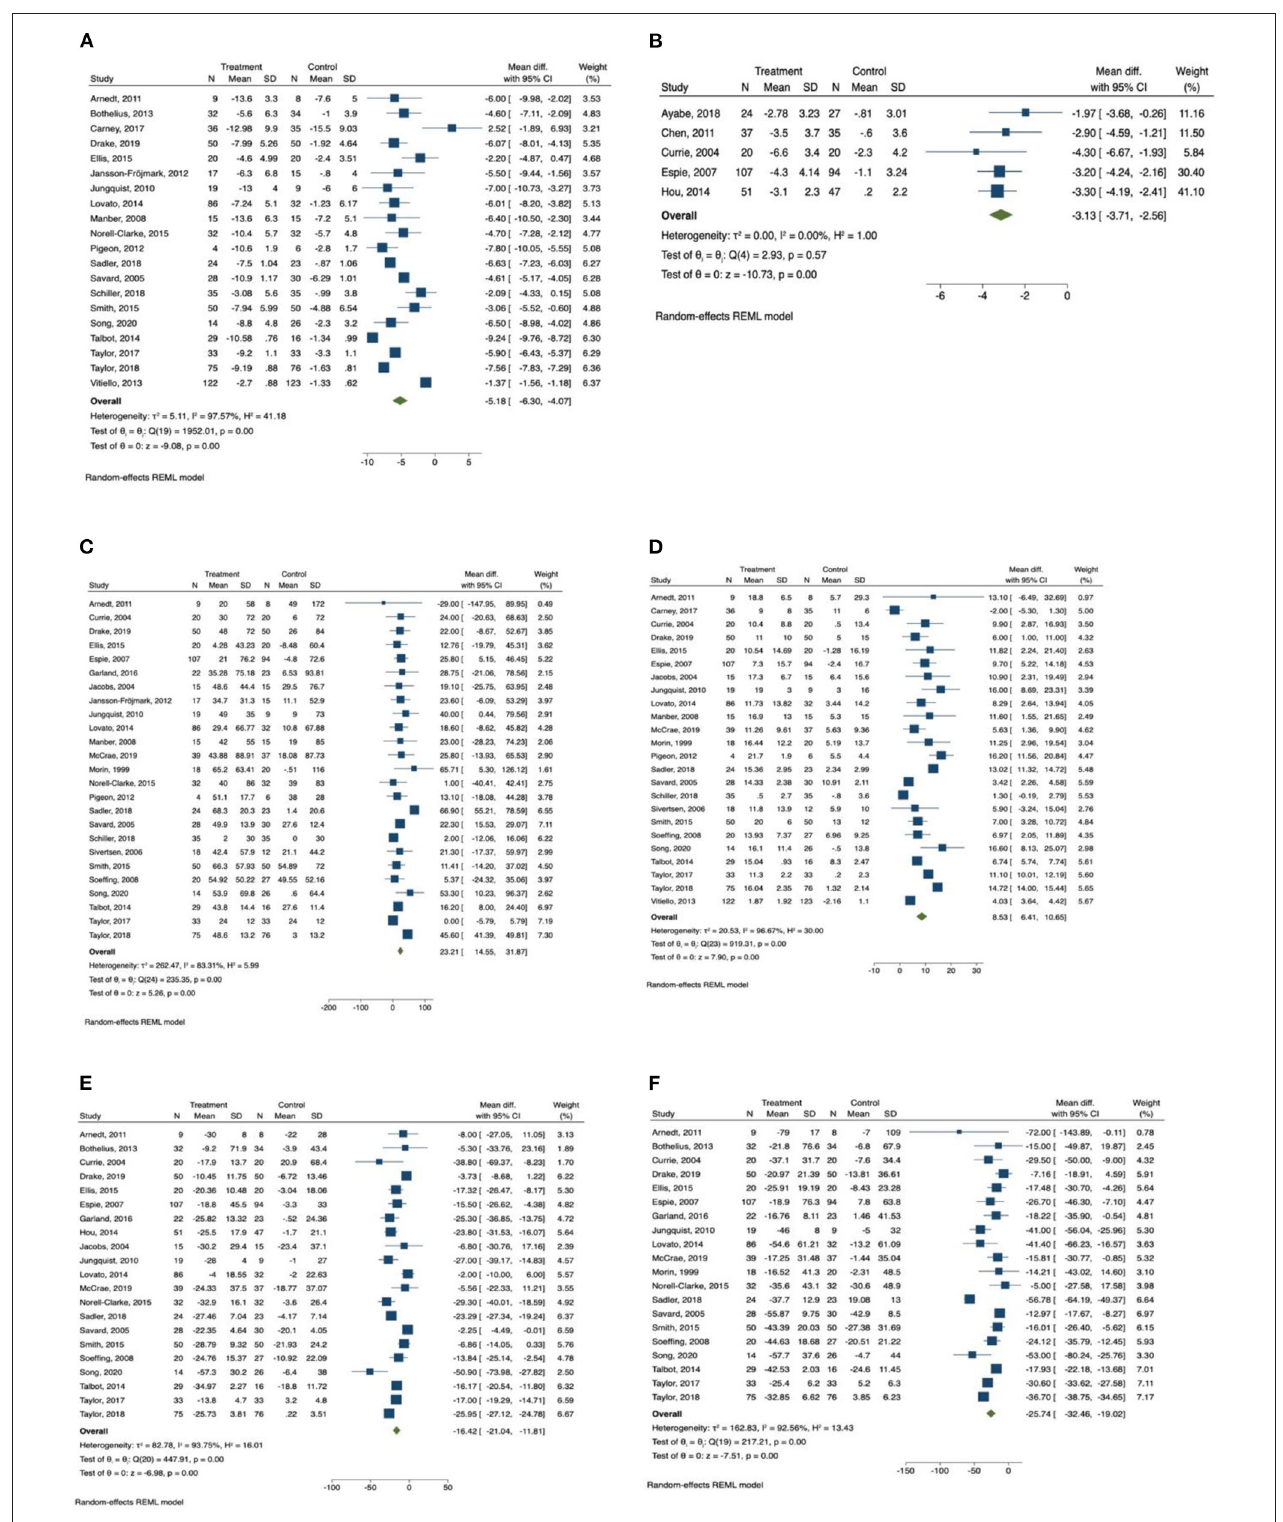
FIGURE 2 | Forest plots of the effect of CBT for sleep outcomes. (A) Insomnia Severity Index, (B) Pittsburgh Sleep Quality Index, (C) total sleep time, (D) sleep efficiency, (E) sleep onset latency, (F) wake after sleep onset.